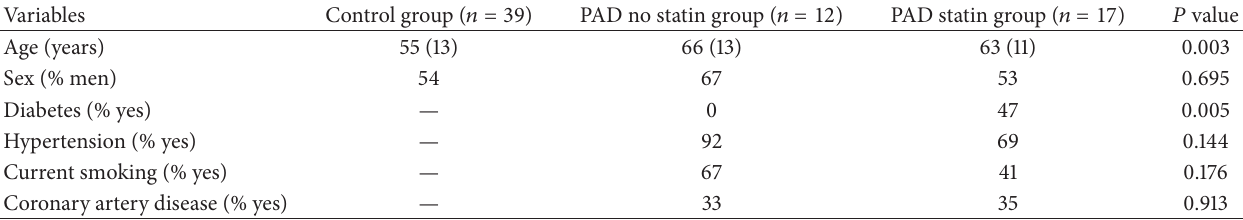
Table 1: Clinical characteristics of subjects with peripheral artery disease (PAD) and controls. Values are means (standard deviation) or percentage of subjects in each category.